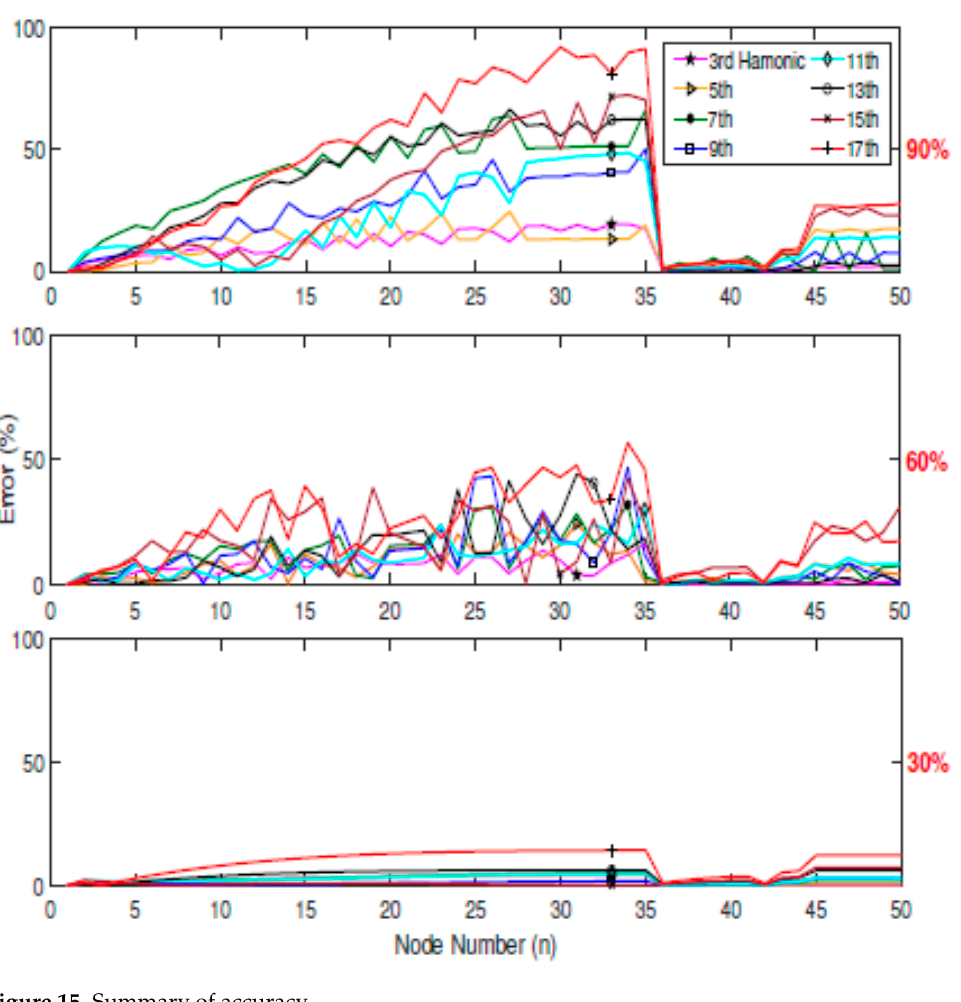
Figure 15. Summary of accuracy.